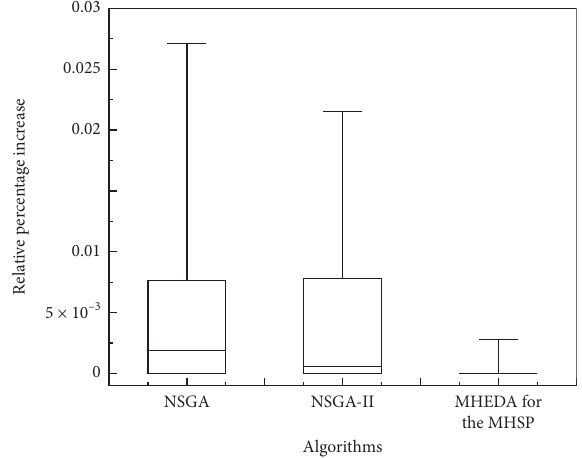
Figure 13: Comparative results for the MHSP using the relative percentage increase.